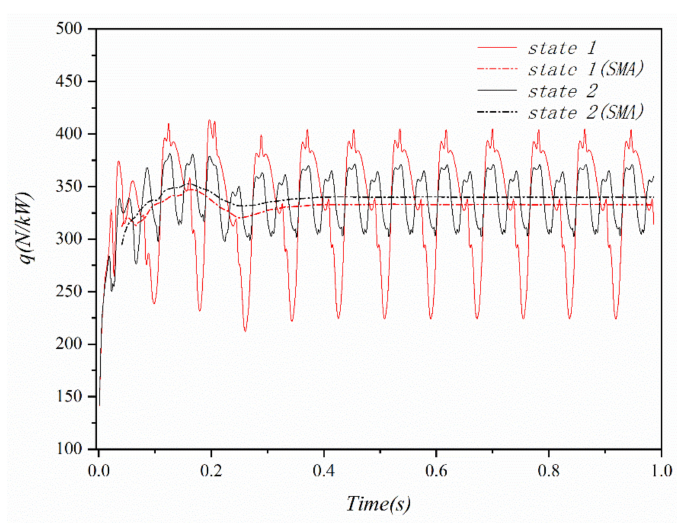
Figure 21. The isolated rotor q in forward